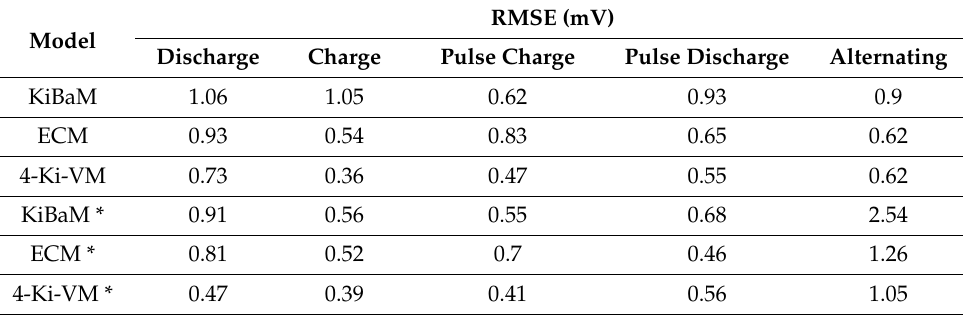
Table 2. Error analysis.